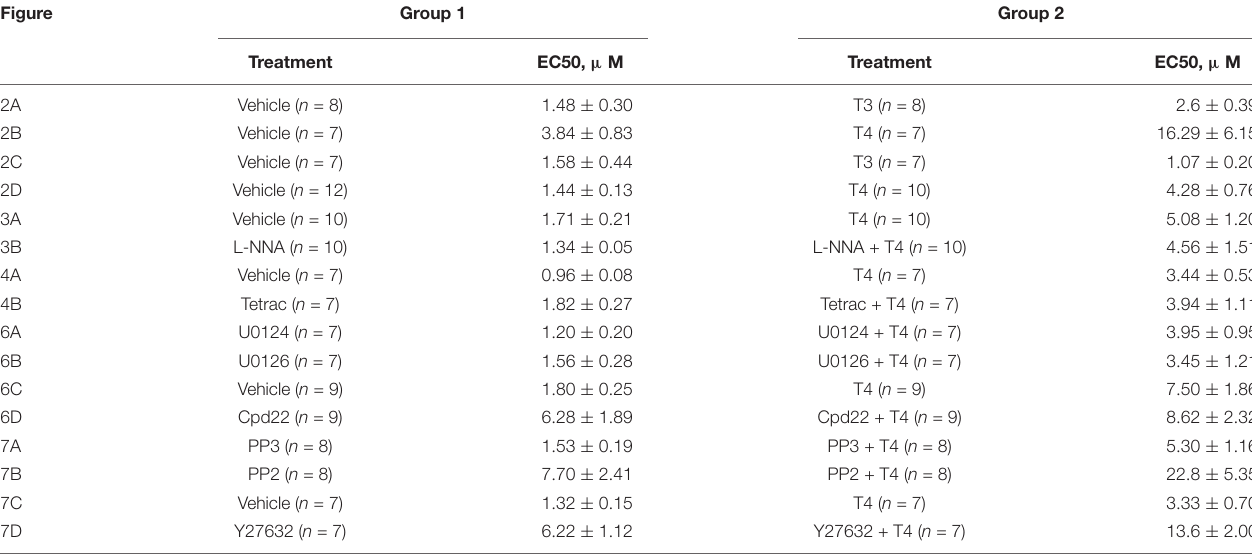
TABLE 1 | Comparison of EC 50 values (concentration evoked half-maximal response) calculated for methoxamine concentration-response relationships shown in Figures 2–4 , 6 , 7 . Figure Group 1 Group 2